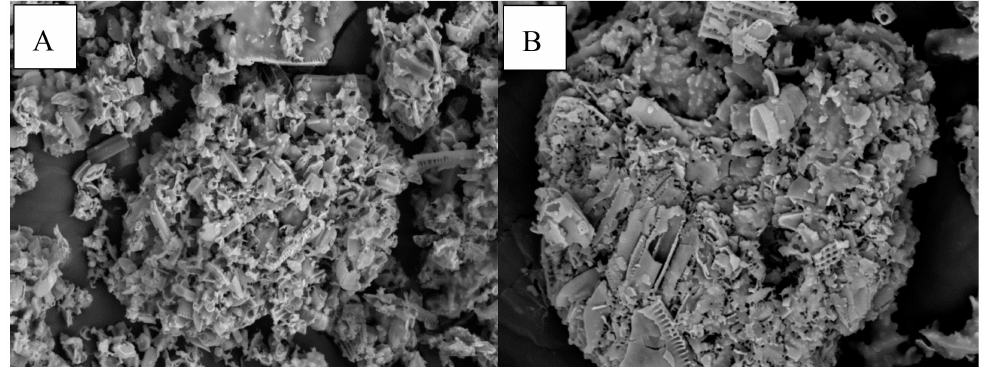
Figure 8. Scanning electron micrographs of chitosan and chitosan with AMS8 lipase. ( A ) Chitosan (500 × magnification); ( B ) chitosan-lipase (1000 ×